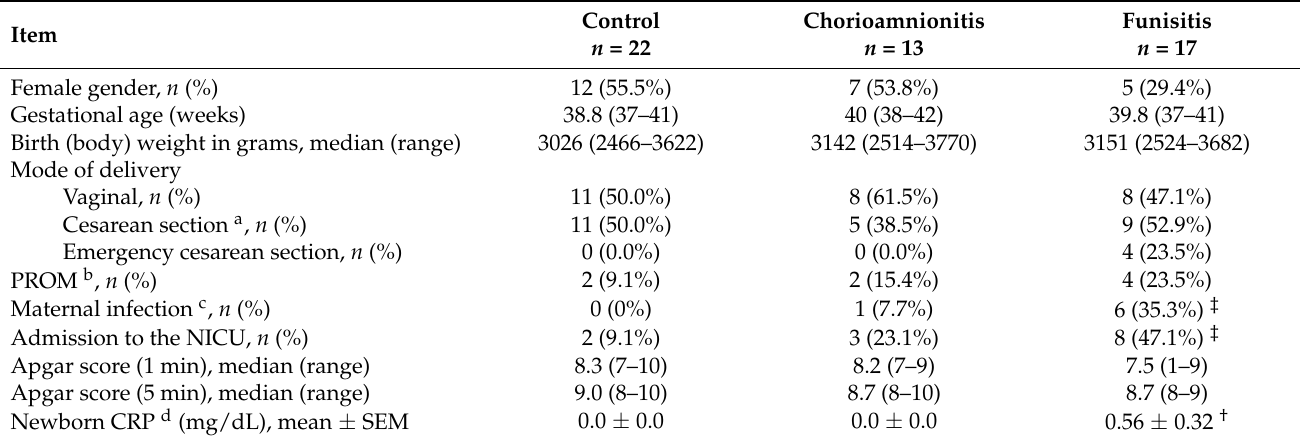
Table 1. Clinical characteristics of the 52 newborns included in the study.